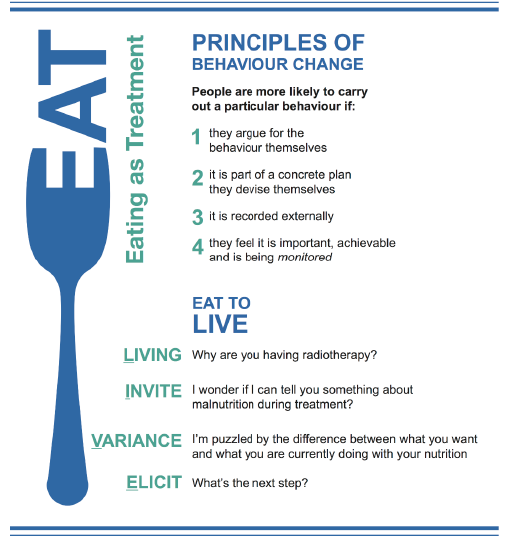
Figure 1. Eating As Treatment (EAT) Intervention: Key principles and prompts for clinicians.